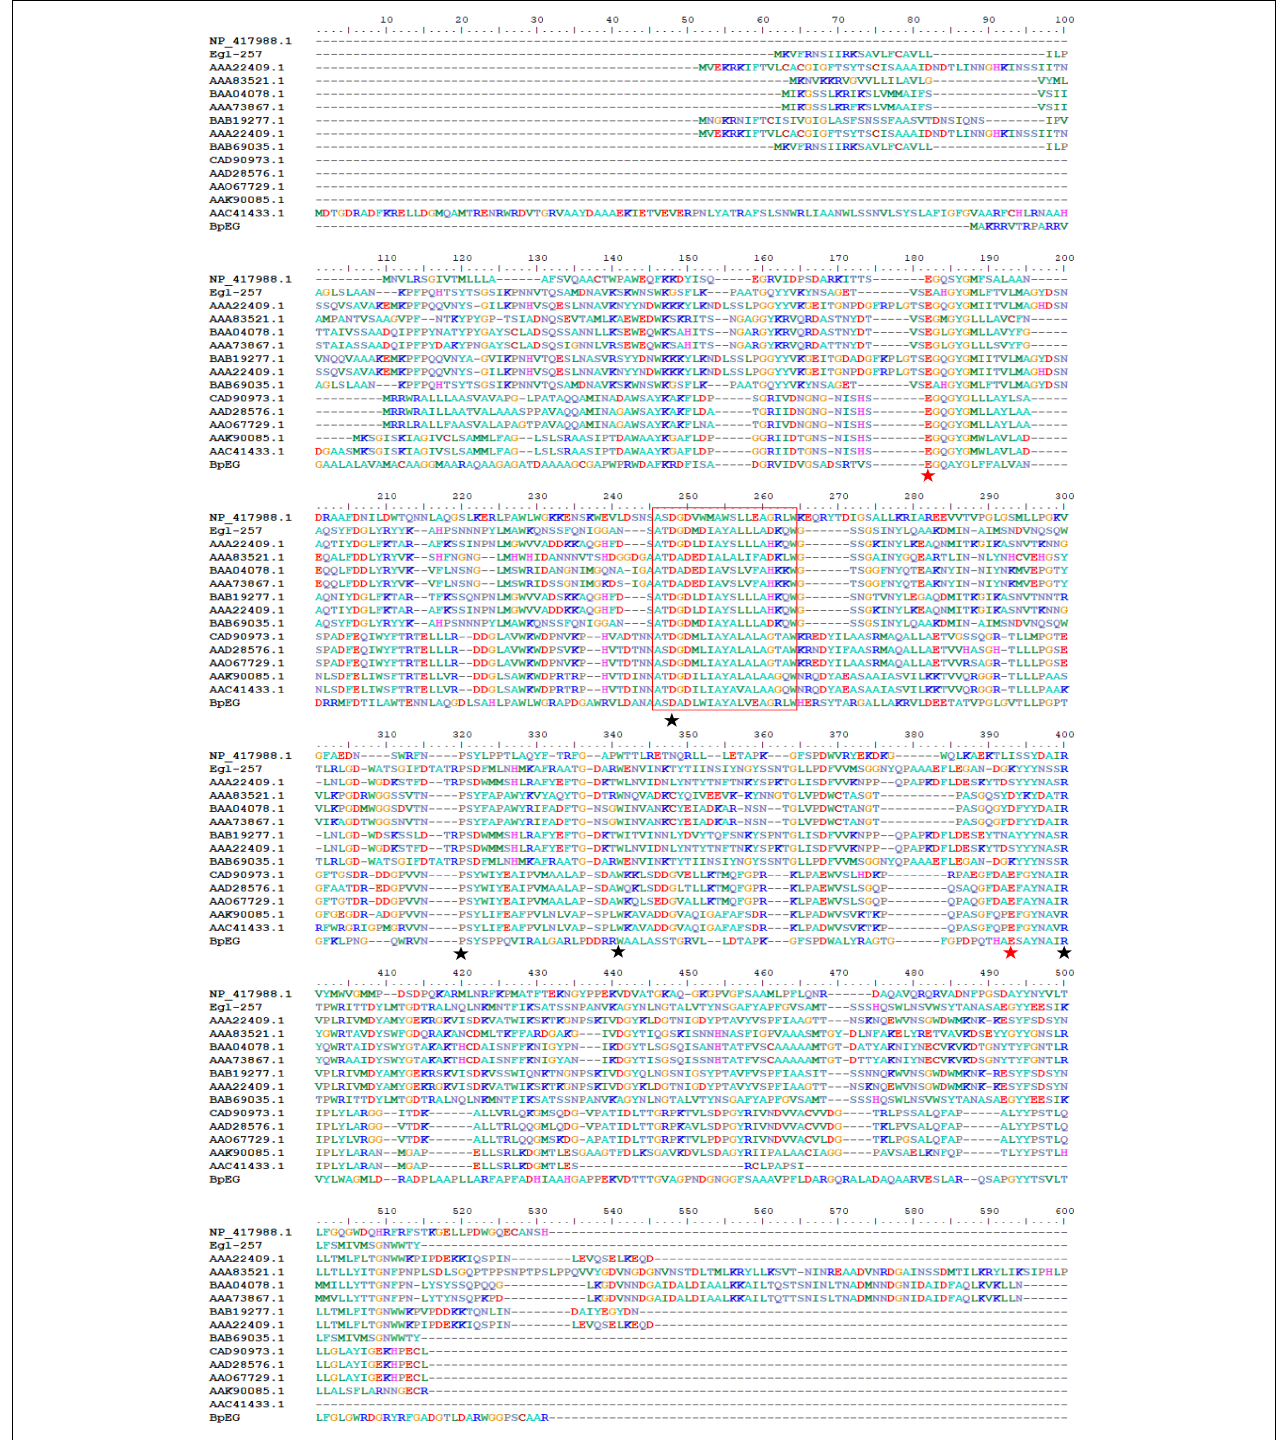
FIGURE 2 | Amino acid sequence alignment of BpEG from B. pyrrocinia JK-SH007 with the family GH8 from Escherichia coli K-12 (NP_417988.1), Bacillus circulans KSM-N257 (Egl-257) (Hakamada et al., 2002), Bacillus sp. KK-1 (AAC27700.1), Clostridium thermocellum NCIB 10682 (AAA83521.1), Clostridium josui FERM P-9684 (BAA04078.1), Clostridium cellulolyticum ATCC 35319 (AAA73867.1), Bacillus sp. No.7-M (BAB19277.1), Bacillus sp. KSM-330 (AAA22409.1), Bacillus circulans KSM-N257 (BAB69035.1), Rhizobium leguminosarum bv. trifolii ANU843 (CAD90973.1), Rhizobium leguminosarum bv. trifolii R201 (AAD28576.1), Rhizobium leguminosarum bv. trifolii 1536 (AAO67729.1), Agrobacterium tumefaciens C58 (Cereon) (AAK90085.1), and Agrobacterium tumefaciens C58 (U. North Carolina) (AAC41433.1) using the ClustalW program. The highly conserved residues and catalytic residues are indicated with black and red asterisks, respectively. Conservative motif was in red